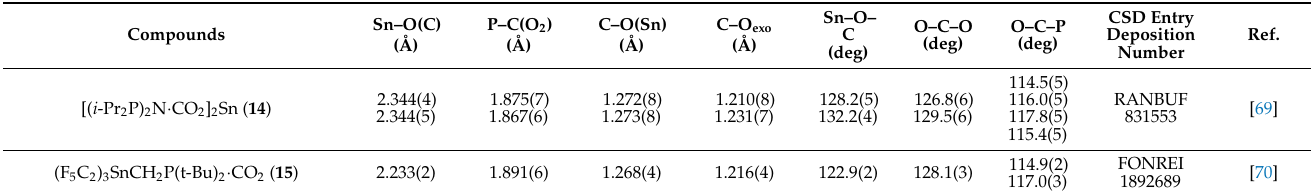
Table 5. Selection of structural parameters found in complexes 14 and 15